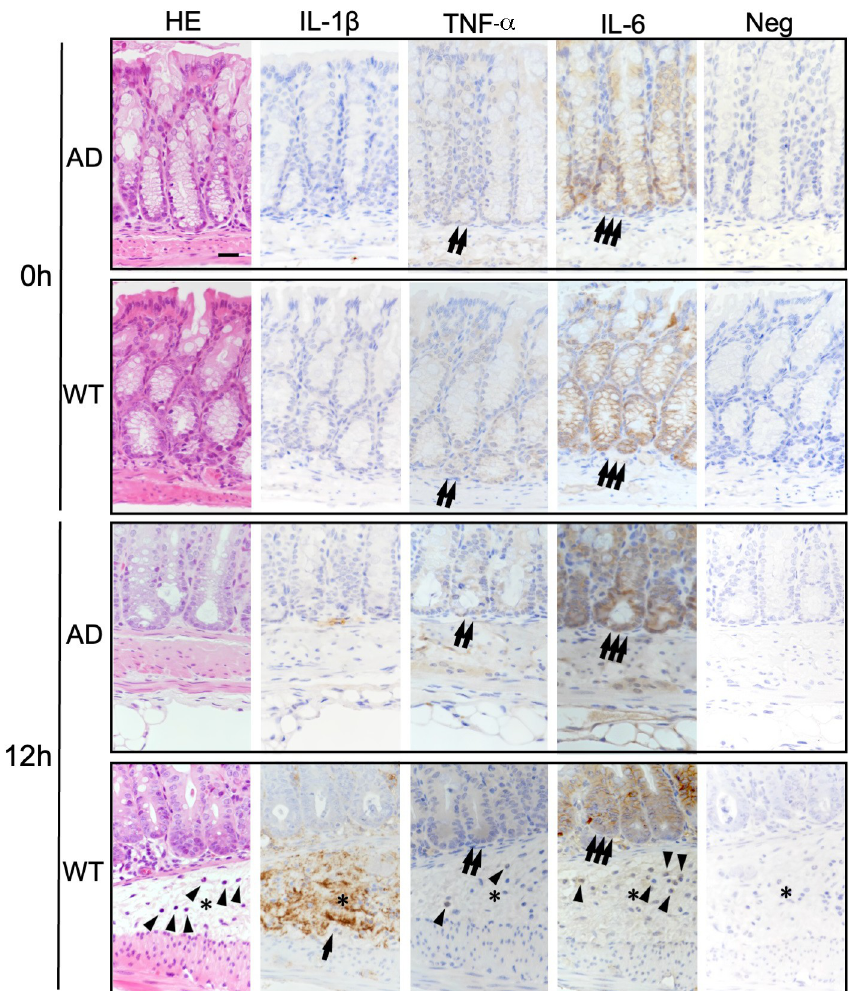
Fig 7. Immunohistochemical comparison of expression of IL-1 β , TNF- α , and IL-6 expression in the colon of WT and AD mice after LPS challenge. Formalin-fixed and paraffin-embedded specimens from colon were stained with hematoxylin and eosin (HE). Serial sections were immunostained with antibodies specific for IL-1 β , TNF- α , or IL-6. A negative control (Neg) (lacking the primary antibody) is also included. Positive staining for IL-1 β , TNF- α , and IL-6 is indicated by an arrow, two arrows, and three arrows, respectively. Asterisks indicate the submucosal edema. Neutrophils are indicated by arrowheads. 0 h, before LPS challenge; 12 h, 12 h after LPS challenge. AD, ASC-deficient; WT, wild-type. Bar = 100 μ